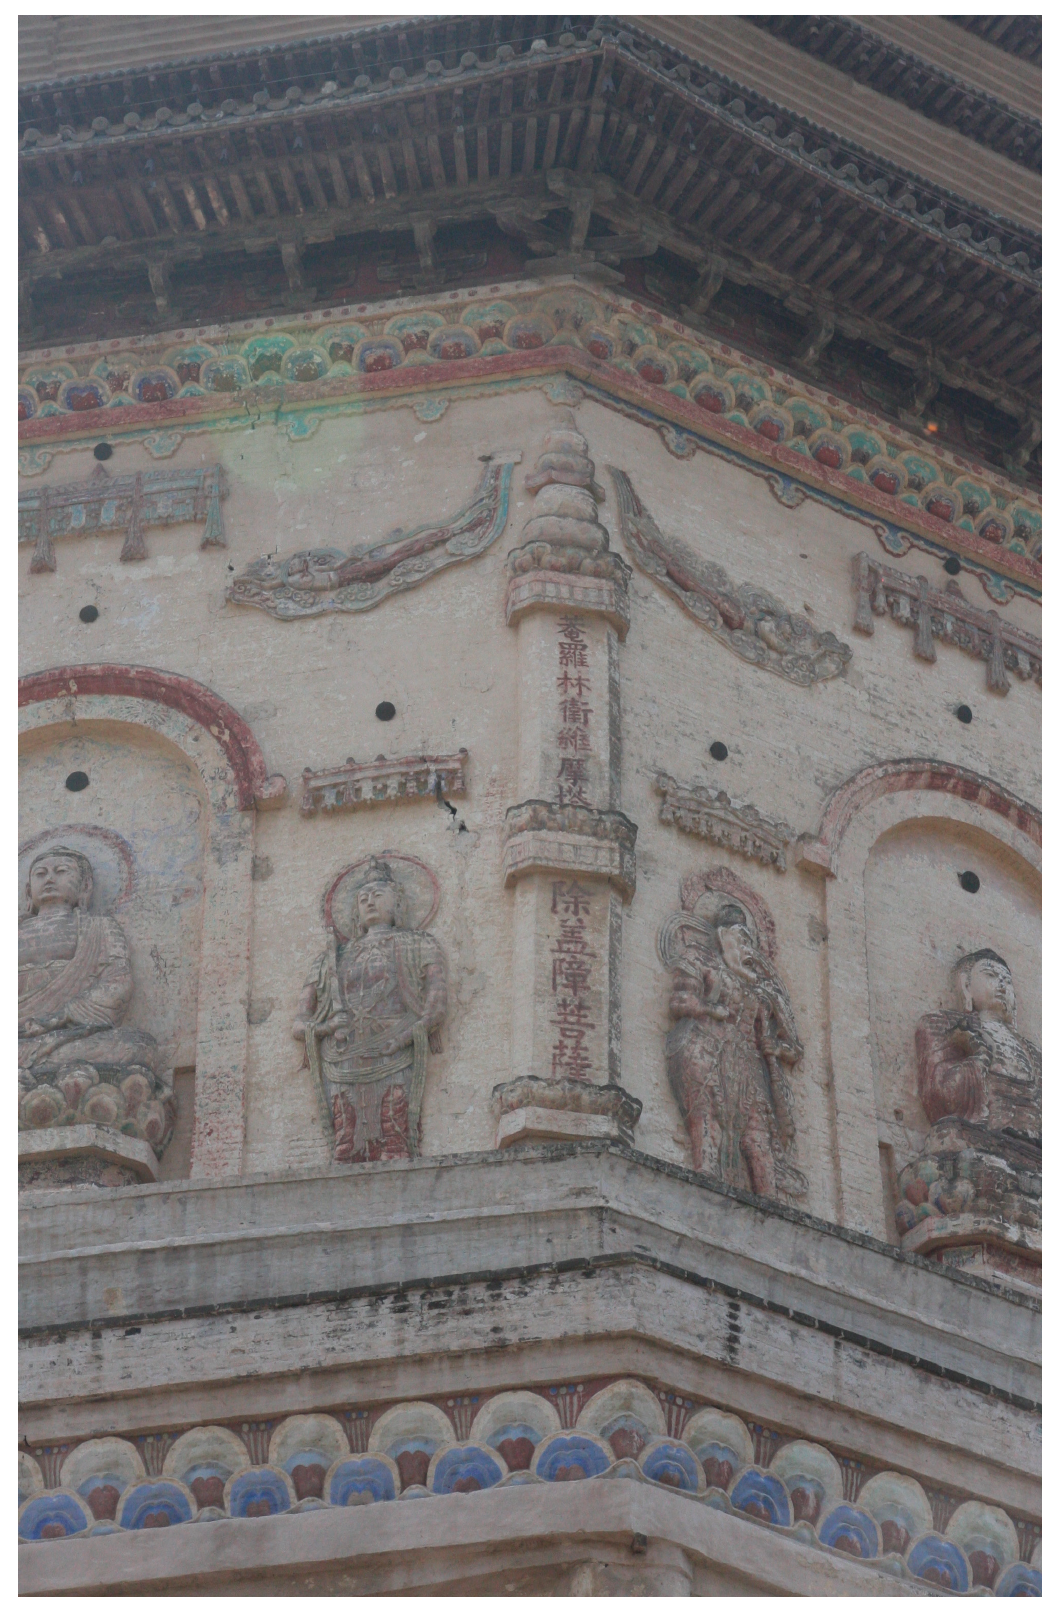
Figure 5. One of the inscriptions of Daming Pagoda, Ningcheng County, Chifeng, Inner Mongolia. Liao dynasty, latter half of the 11th to the early 12th century [©Photograph by Youn-mi Kim, 2009].